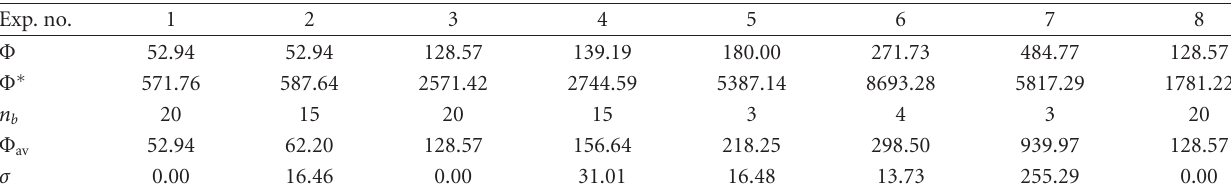
Table 3: Findings for each